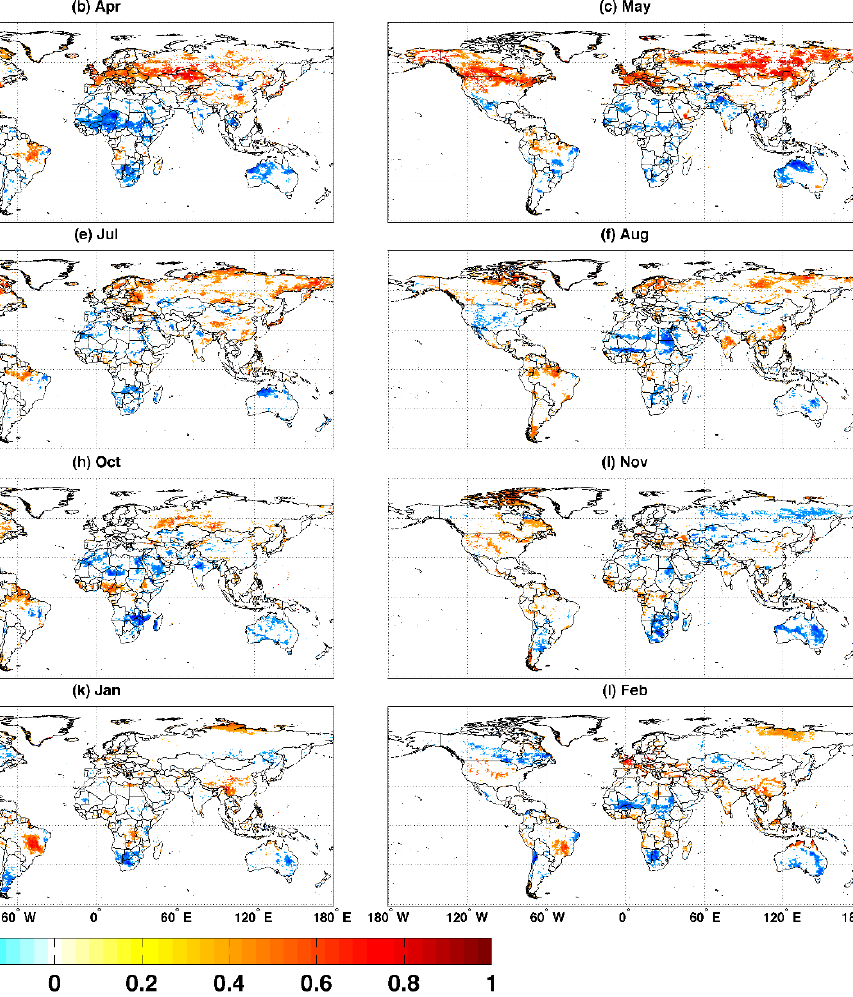
Figure 7. Global maps of correlation coefficients ( p < 0.05) between month-specific GIMMS NDVI and GISS temperature anomalies at lead 0 for 1982 – 2010 (N = 29) for the 12 months of the year ( a – l ), after removal of grid cells with significant ( p < 0.05) negative correlation between GIMMS NDVI and MODIS Terra snow cover (Spatial resolution: 0.5°. NH: Northern Hemisphere; SH: Southern